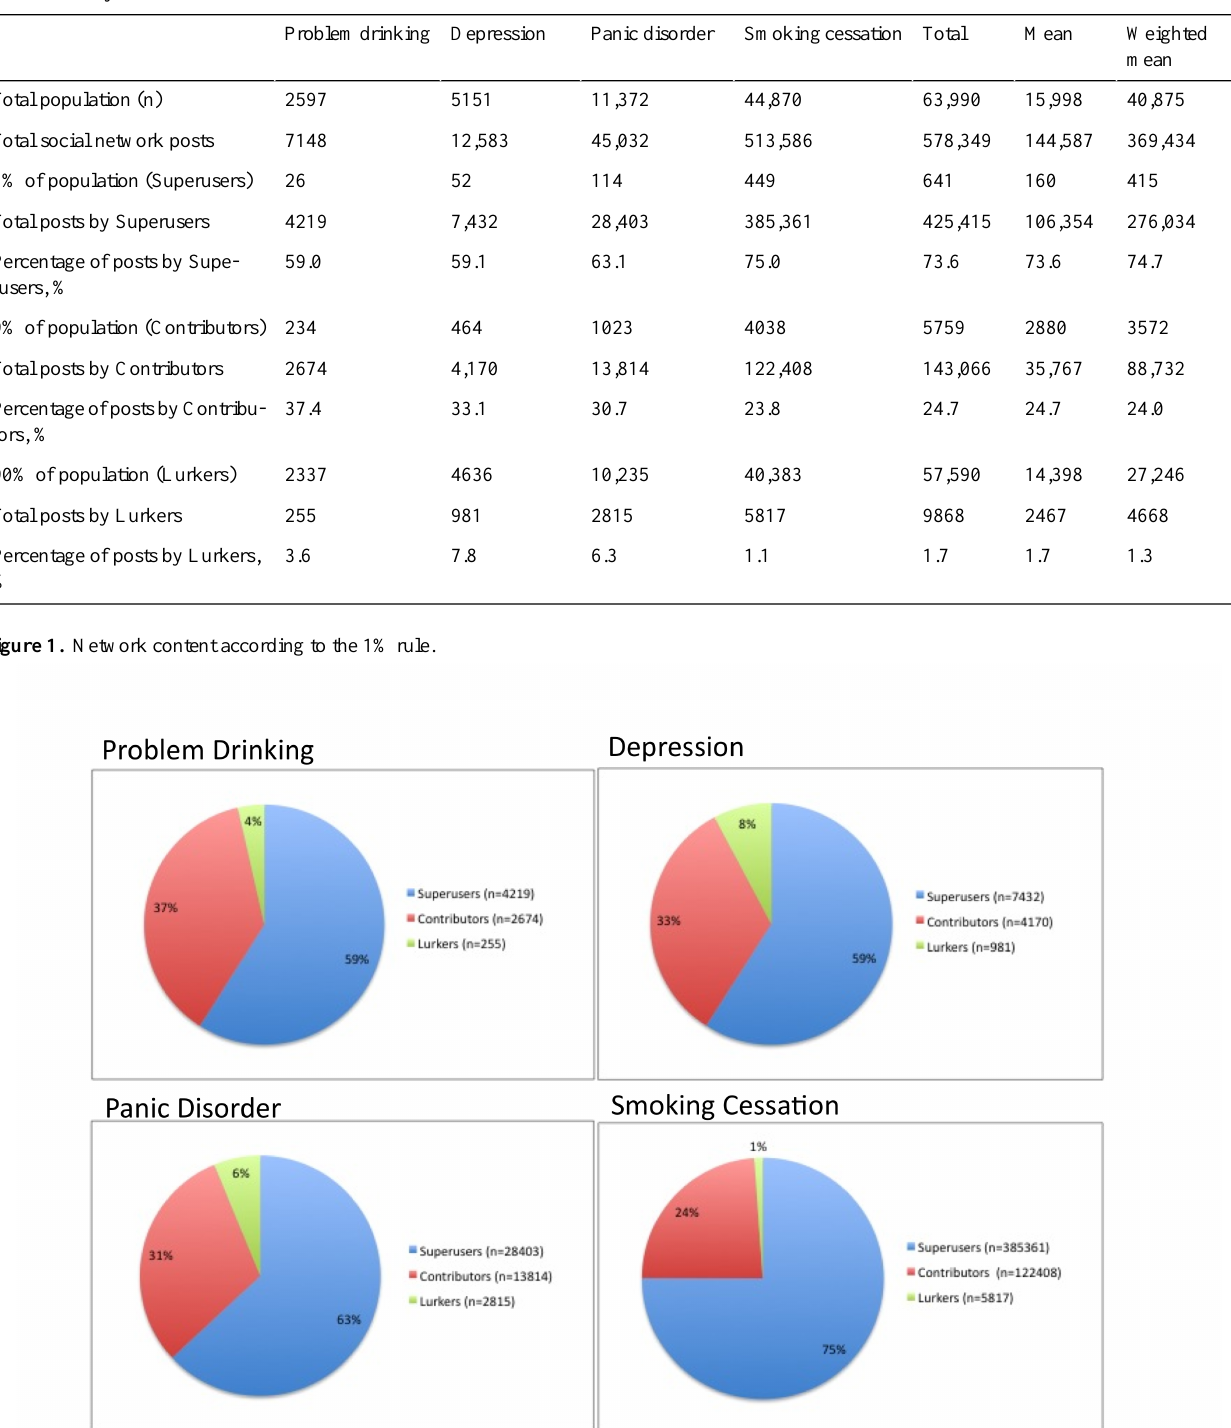
Table 4. Analysis of the 1% rule.